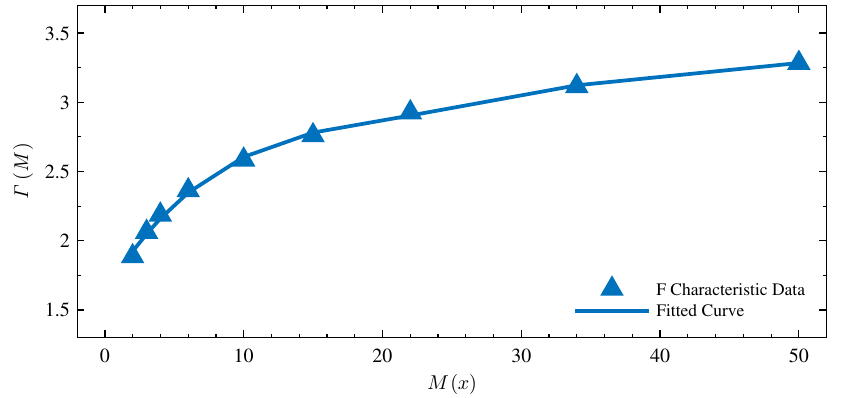
Figure 5. Fitting results of fracmemristance for the chain-scaling fracmemristor circuit. The relationship curve between the memristance M ( X 0 ) and F-frequency characteristic curve value shown in Figure 5 is fitted by the least squares method. The resulting relation